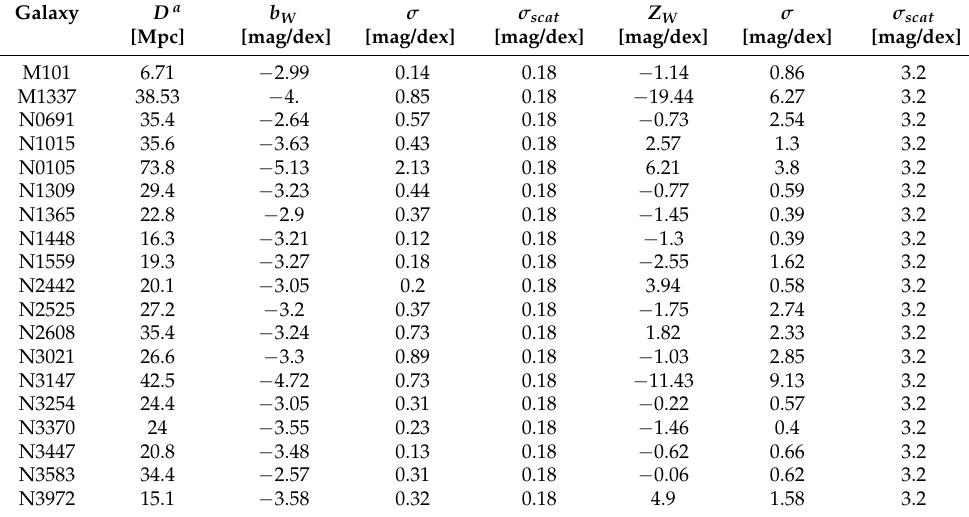
Table A1. The best-fit individual slopes b W and Z W with their standard errors σ and scatter uncer- tainties σ scat . The scatter uncertainty ensures that the model of a universal best-fit slope becomes an acceptable model with χ 2 / dof (cid:39) 1, as described in Section 2.2. The number of hosts in the Table min is N = 42, including the Milky Way (MW). For LMC and SMC, the metallicities are not provided individually for each Cepheid in R21, and thus no Z W slope could be estimated in our analysis.